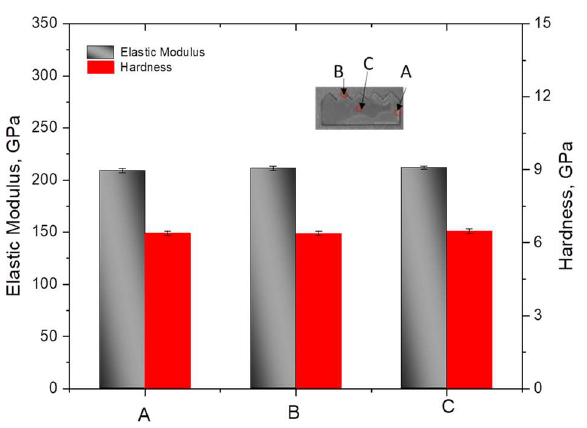
Figure 5. Elastic modulus and hardness of micro saw at areas A, B, and C, obtained using nanoindentation.